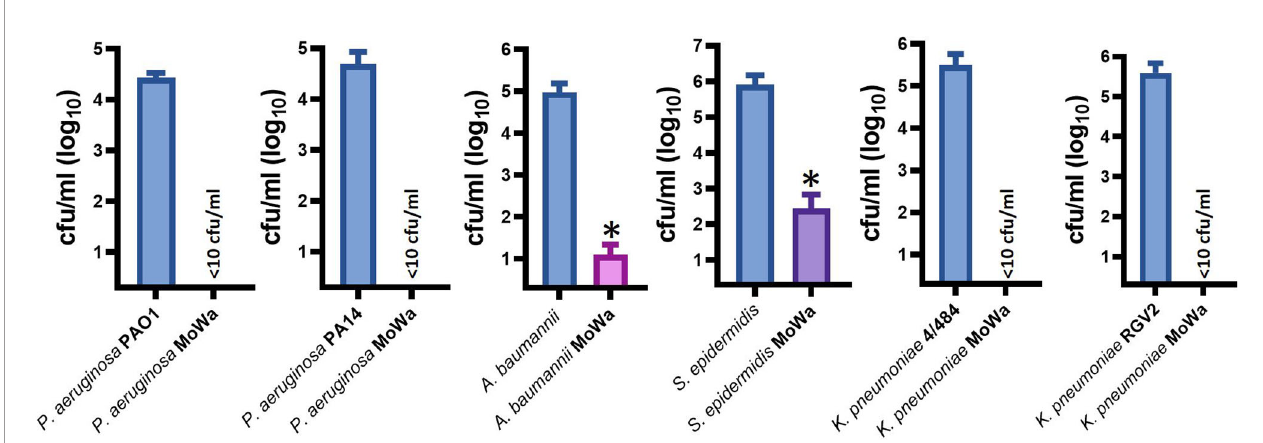
FIGURE 5 | MoWa ef fi ciently decontaminate surfaces containing nosocomial pathogens. The indicated bacterial strain was inoculated in a 10-cm2 sterile surface and let dry for ~1 h. Contaminated surfaces were sprayed with PBS (control) or with a mixture levulinic acid (LA) and SDS at a concentration of 1/0.04 M. Bacteria were removed from MoWa-treated or mock-treated surfaces after 1 min and immediately diluted and plated onto BHI agar plates to obtain colony counts (cfu/ml). Error bars represent the standard errors of the means calculated using data from at least three independent experiments. *p<0.05 compared to control.